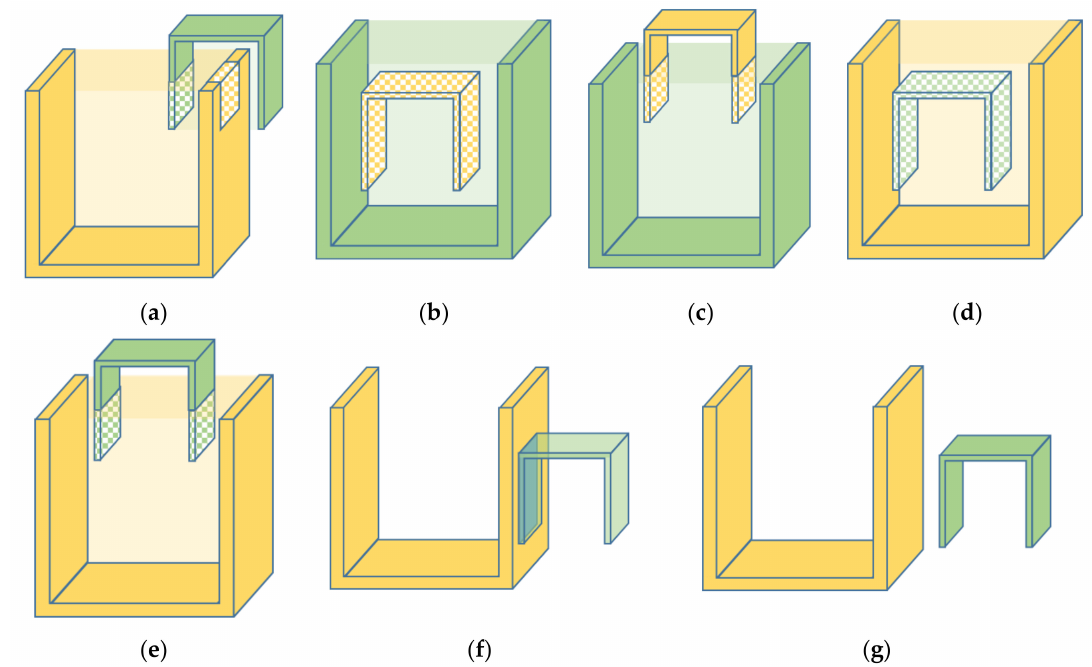
Figure 2. The spatial topological relations between two point clouds. The yellow area and the green area mean the region of point cloud A and B , respectively. The light yellow and light green areas represent the region of the convex hull of A and B , respectively. ( a , b ) are di ff erent spatial topological relations. ( a ) Cross; ( b ) Within; ( c ) Partial within; ( d ) Contain; ( e ) Partial contain; ( f ) Touch; ( g )